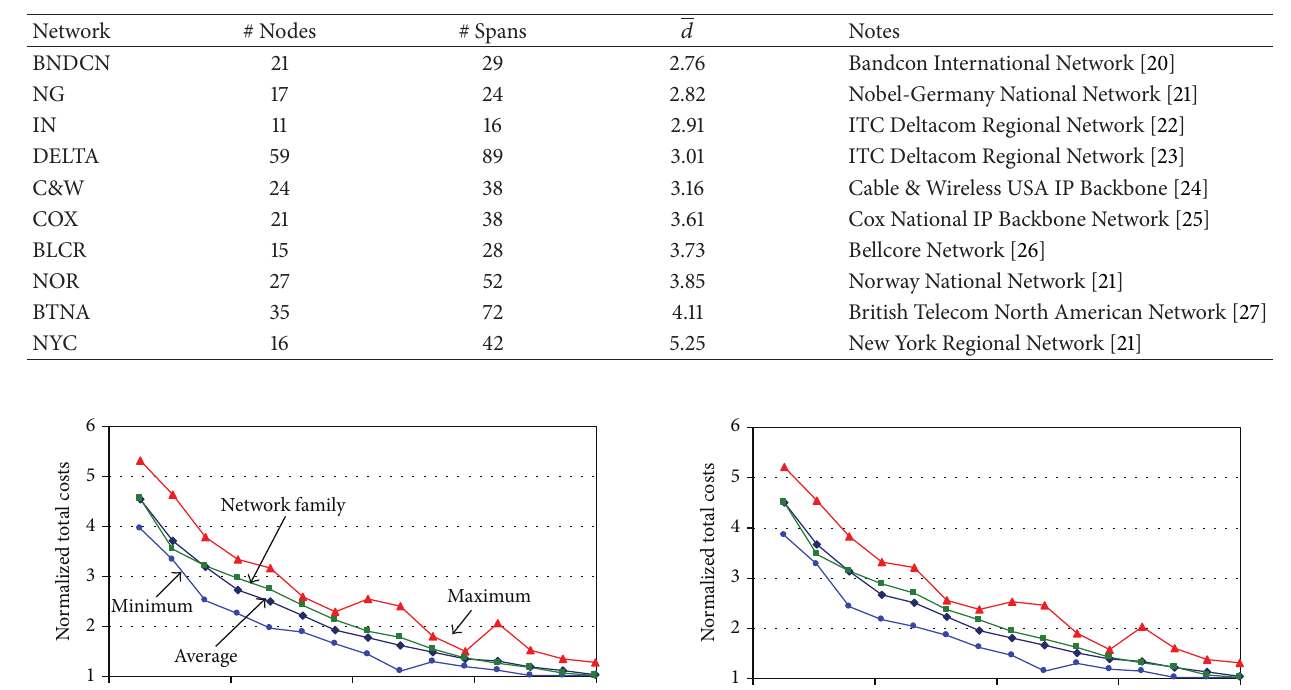
Table 1: List of implemented networks used in this study.